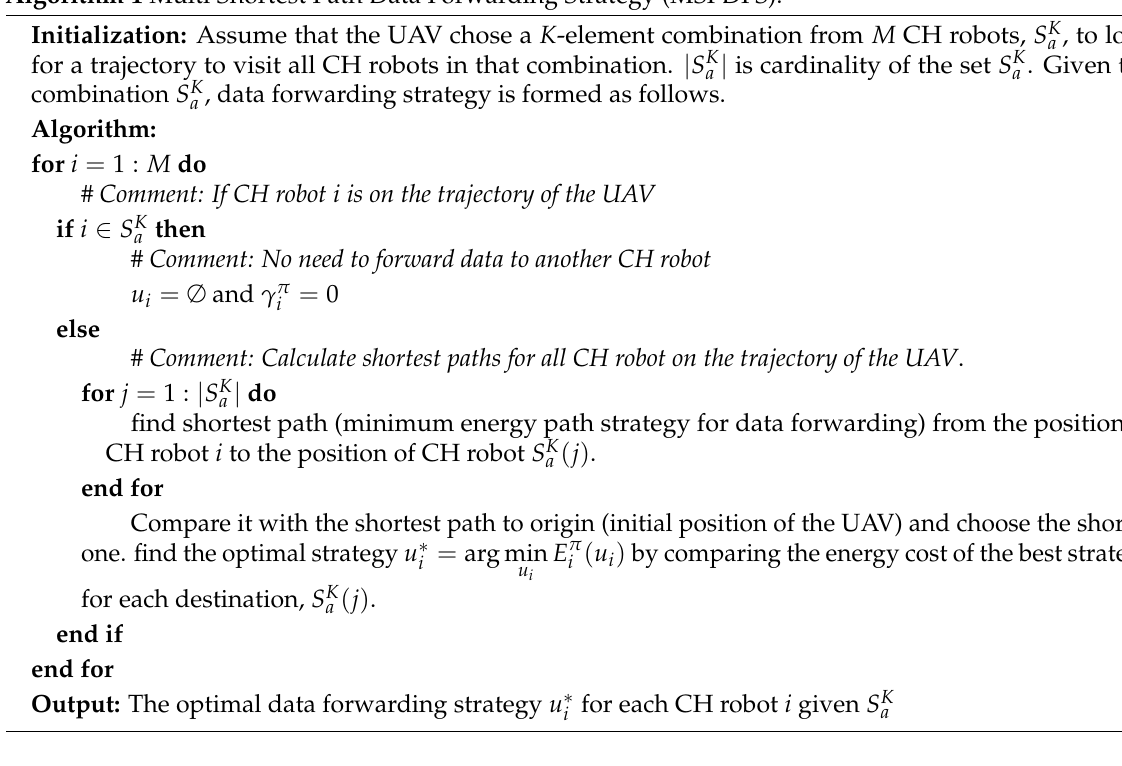
Algorithm 1 Multi Shortest Path Data Forwarding Strategy